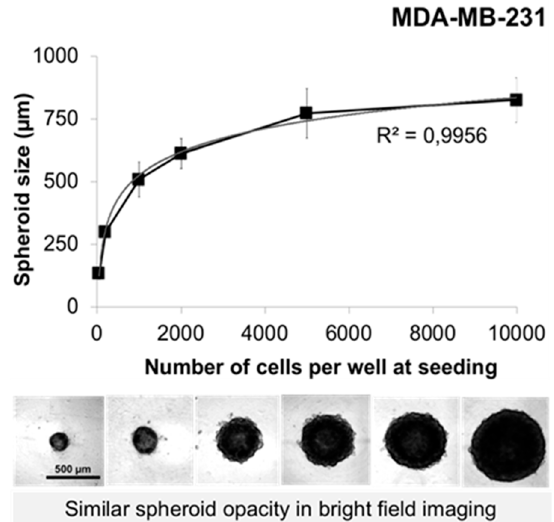
Figure A1. Estimation of spheroid level of compaction by the correlation between the number of seeded cells and the size of spheroids formed (bright field imaging, Cytation3MV). The regression (R 2 = 0.9956) indicates the proportionality between cell seeding concentration and spheroid size. The spheroids formed from each cell seeding concentration are equally round and opaque to light.